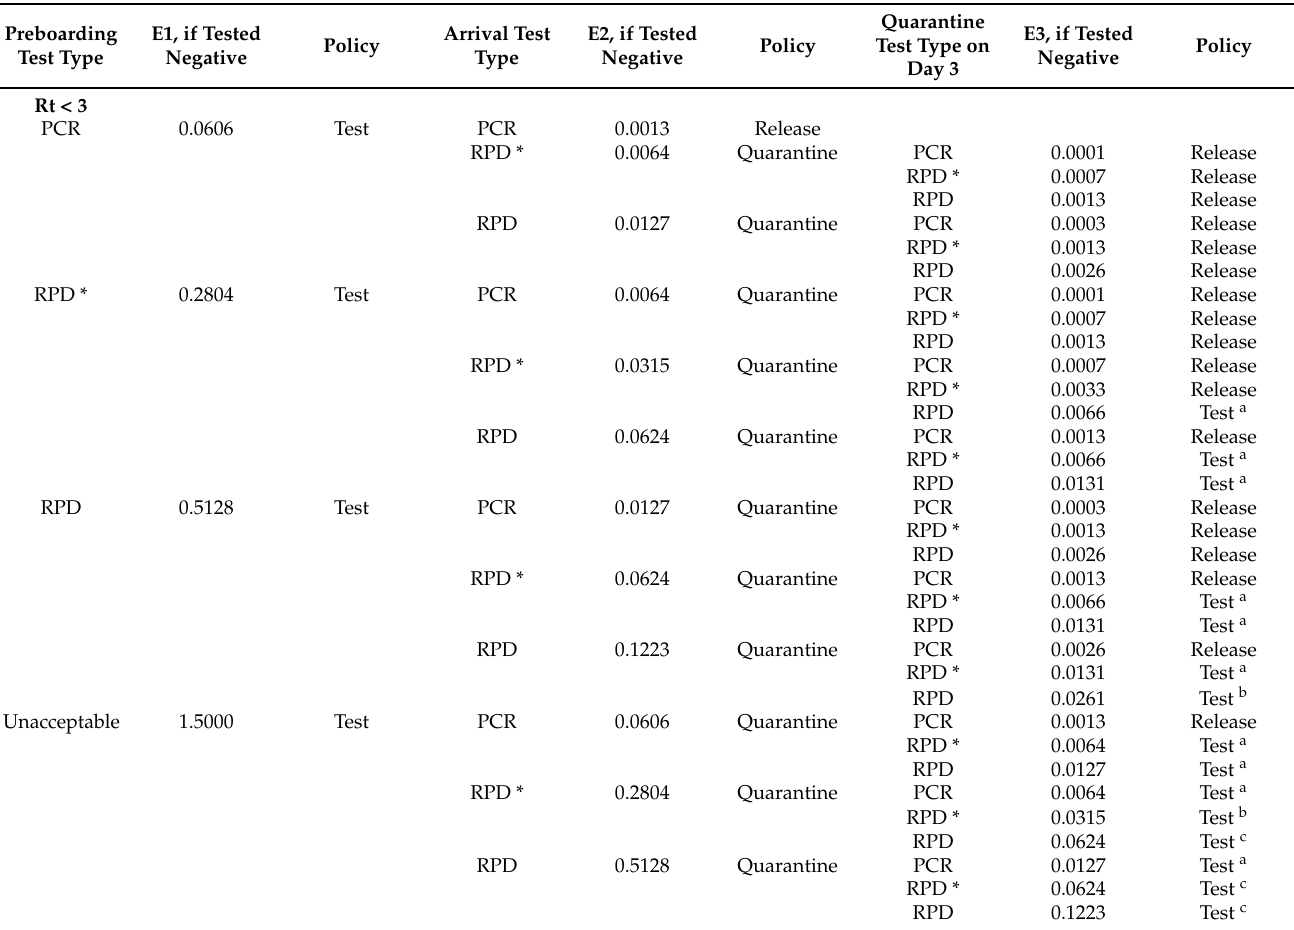
Table 3. Testing and quarantine strategies for unvaccinated